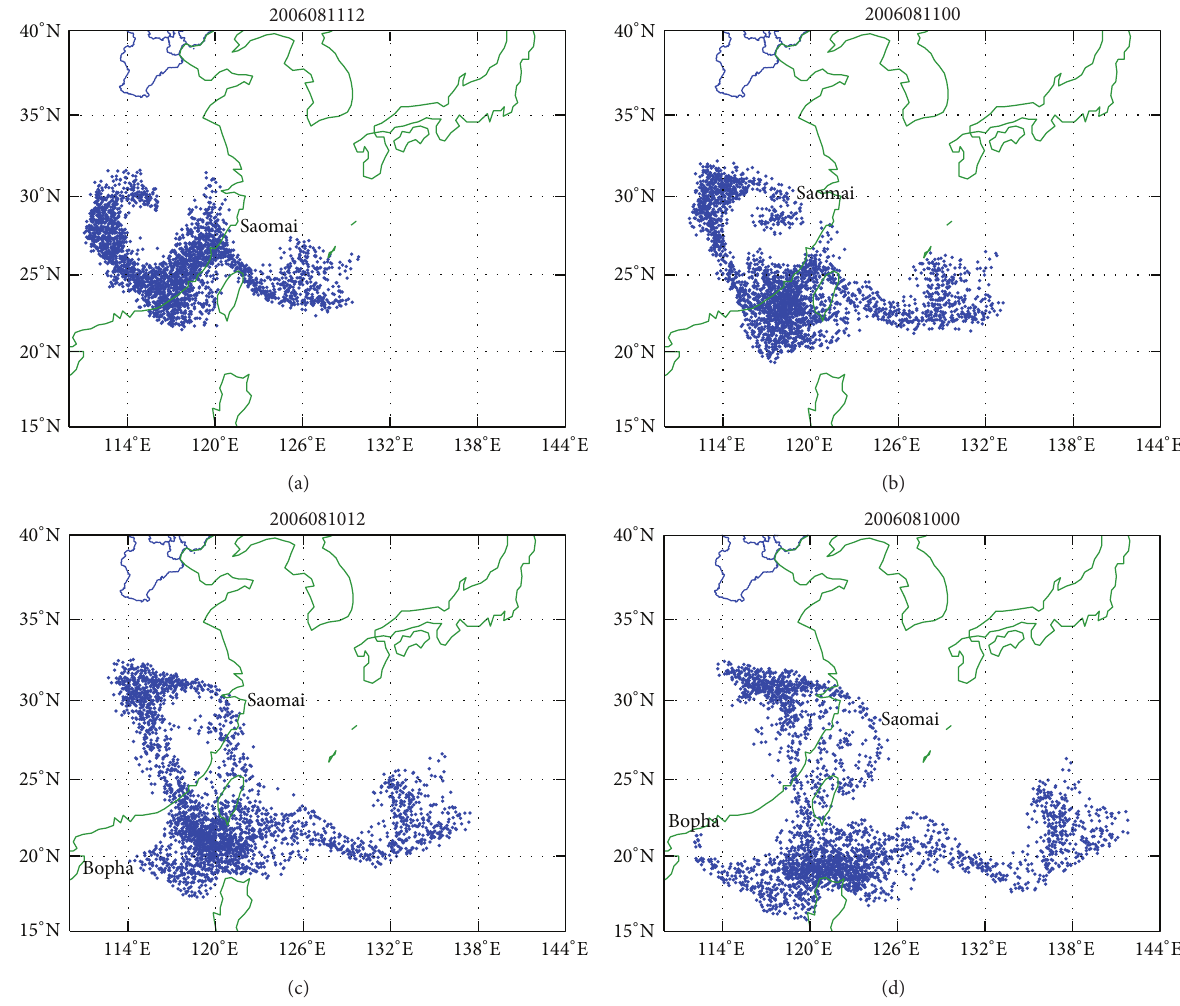
Figure 12: Back trajectories of the cluster of moisture particles released at 0000 UTC 13 August in Saomai (114.5 ∼ 120.5 ∘ E, 26 ∼ 33.5 ∘ N) in the